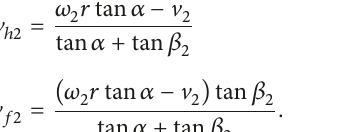
Figure 3: Structure parameters of EA and DA ( 𝑟 1 , 𝑟 2 , and 𝑟 are the innerradius,outerradius,andmiddleradiusofthescrewflight,resp. 𝛼 is the screw angle. 𝑁 is the number of the screw flights. 𝐿 1 and 𝐿 𝑟 2 are the lengths of EA and DA, resp. 3 is the inner radius of the storage room; 𝐻 𝑐 is the maximal height of the storage room. 𝑃 is the screw pitch. 𝑤 is the width of the screw